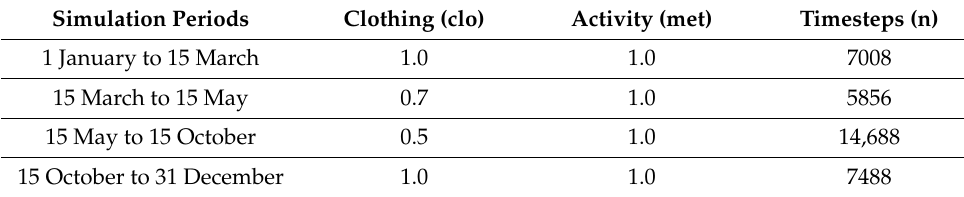
Table 6. Simulation periods depending on the clothing